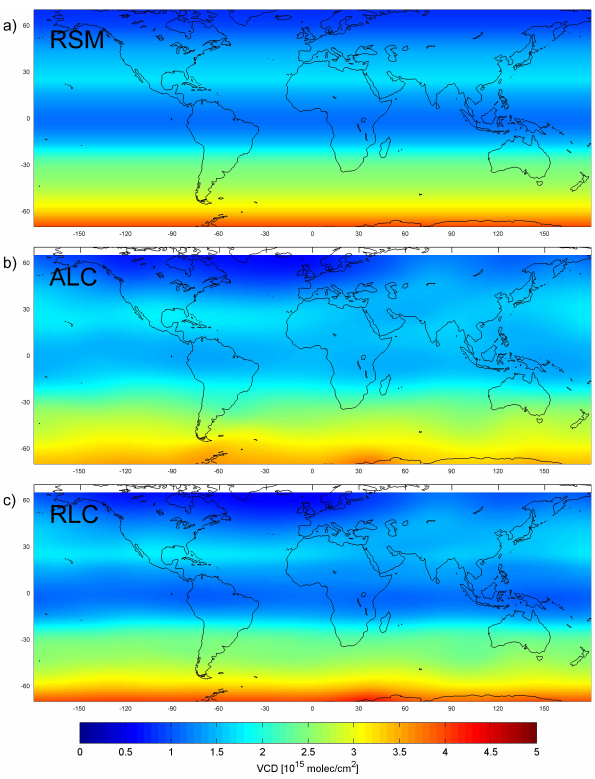
Fig. 6. Tropospheric SCDs for 28 January 2006. (a) T RSM : refer- ence sector method. (b) T ALC : absolute limb correction. (c) T RLC : relative limb correction. Crosses mark the locations considered in the time-series analysis (see Figs.